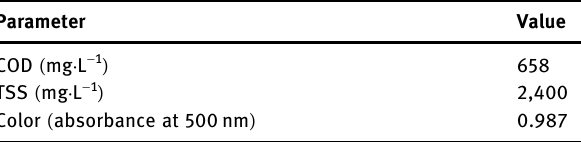
Table 1: The parameters of batik ’ s wastewater quality Parameter